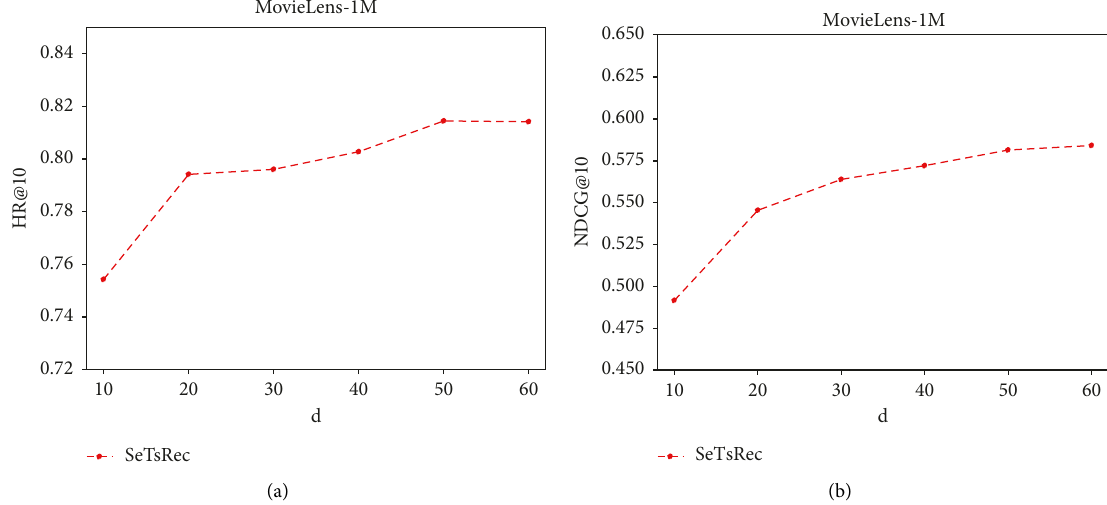
Figure 6: Experiment results of different latent dimension d on ML-1M. (a) Results on HR@10. (b) Results on NDCG@10.